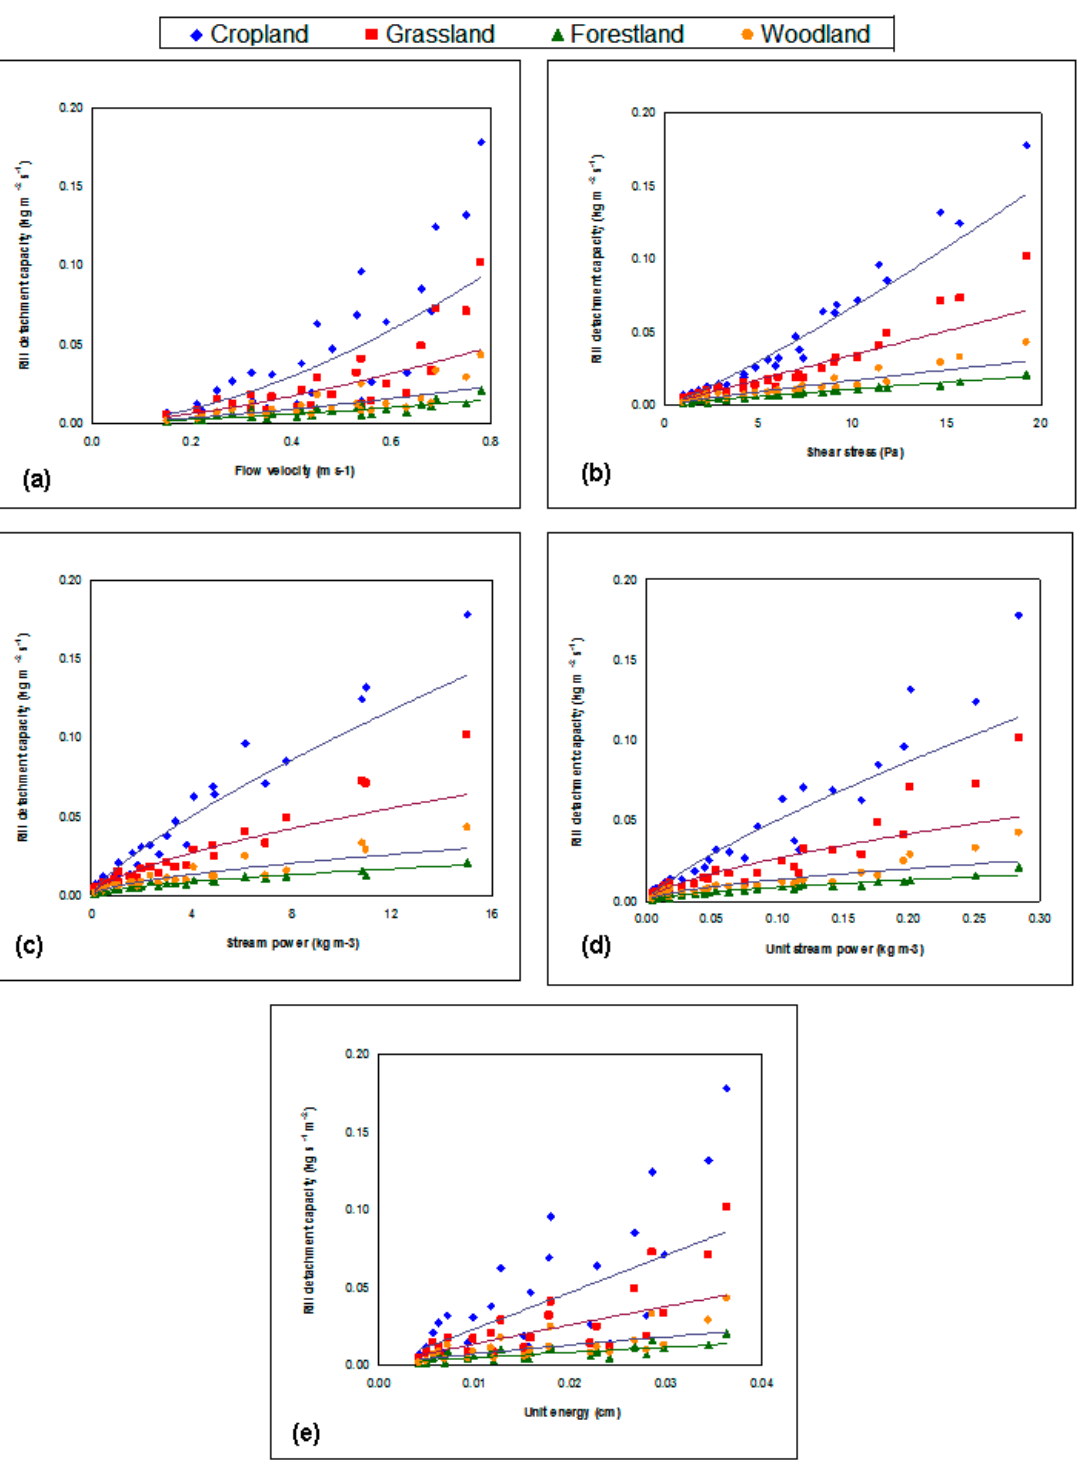
Figure 5. Correlations between the rill detachment capacity (D c ) and five hydraulic parameters using equations of Table 5 for the four land uses of the Saravan watershed (Northern Iran) ( n = 25). ( a ) D c